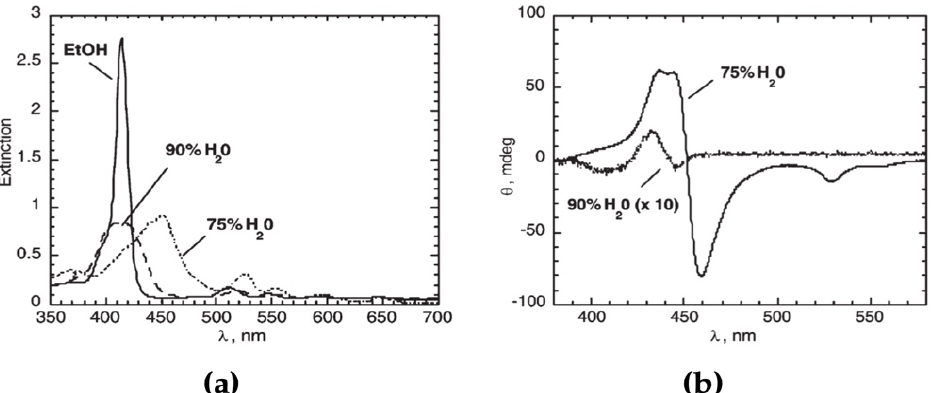
Figure 1. ( a ) UV-Visible spectra of the aggregates of H 2 P(L)Pro(+) in different hydroalcoholic media; the spectrum in non-aggregative conditions (pure ethanol) is reported for comparison. ( b ) Compari- son of the CD spectra of the aggregates obtained from different water-containing solvent mixtures. Adapted from [41], with permission from the Royal Society of Chemistry, Copyright © 2005.